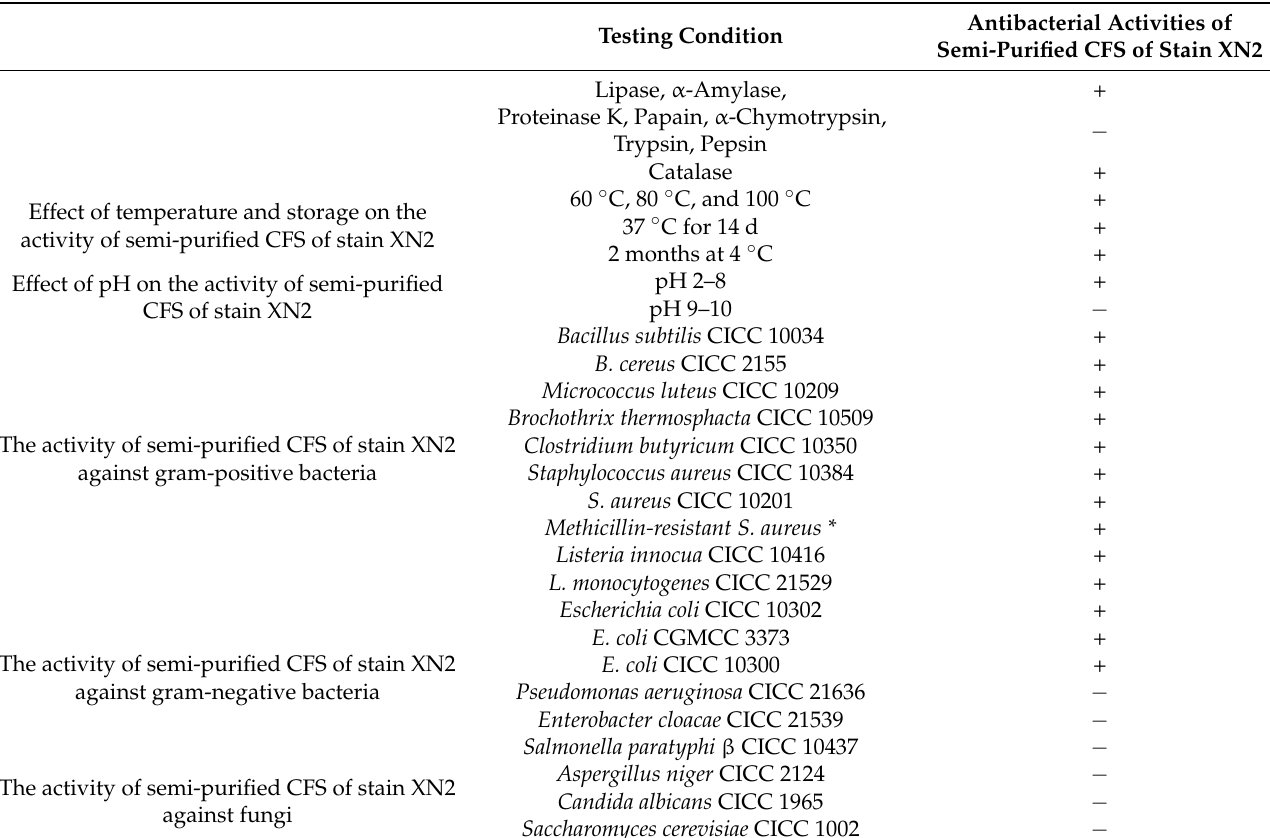
Table 1. Effect of enzymes, temperature, and pH on bacteriocin XN2. Testing